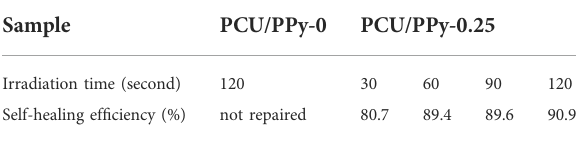
TABLE 3Theseal-healing ef fi ciency ofPCU/PPy-0